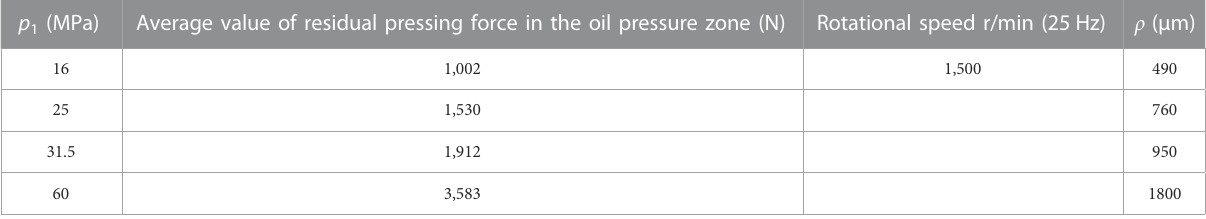
TABLE 3 Height of the convex peak of the simulated specimen on the inclined disc. p 1 (MPa) Average value of residual pressing force in the oil pressure zone (N) Rotational speed r/min (25